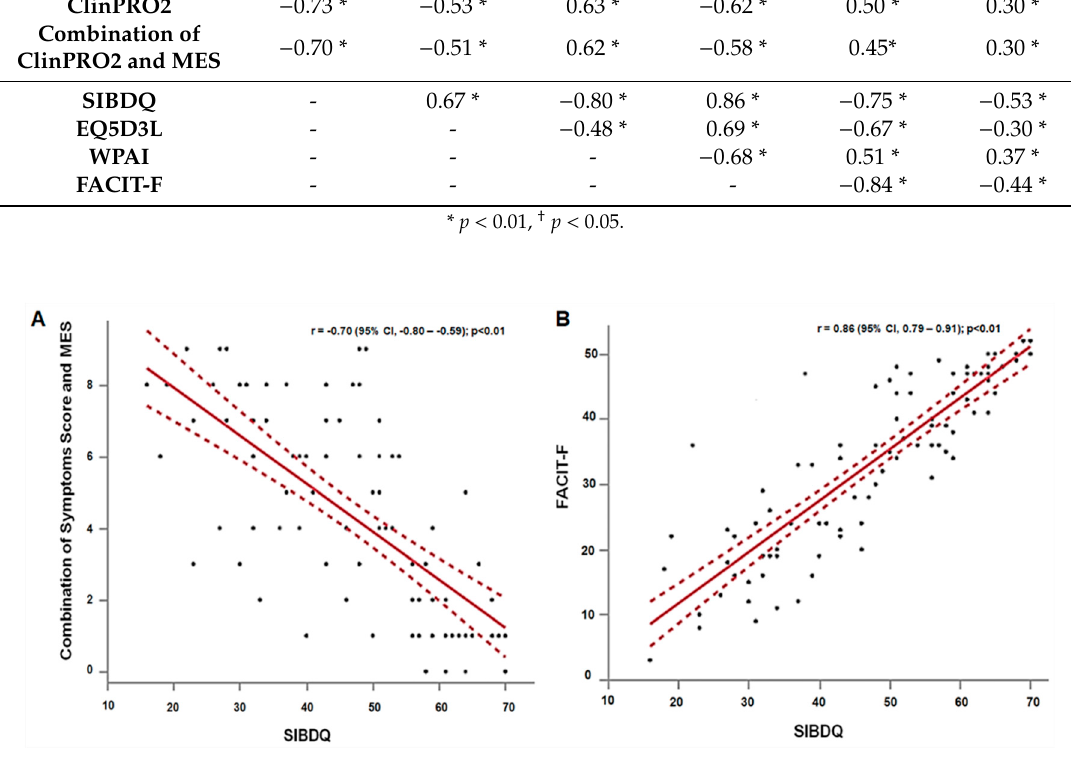
Table 3. PROs in UC patients categorized by ClinPRO2 and mucosal healing. UC Patients Categorized by